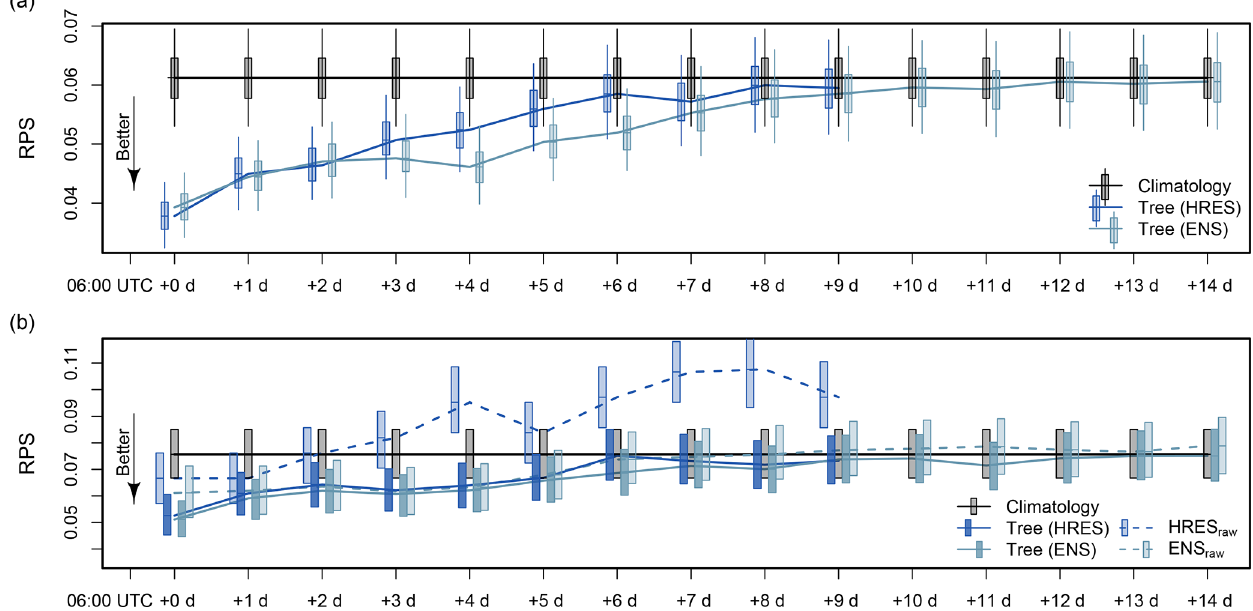
Figure 3. Medium-range forecast performance of boosting trees based on HRES and ENS information, and the reference models with their uncertainty (boxes show the 25th to 75th percentile range, and whiskers show the 5th to 95th percentiles). (a) Median forecast performance of the statistical models and climatology for the complete 6 years of data (cold season only). (b) Median forecast performance of the statistical models and the references climatology and raw NWP model output (HRES raw , ENS raw ) for December 2016–March 2017 and October– November 2017 only. The lvp state from the raw ensemble is computed from the distribution of the lvp states from each member. Computing the lvp state from only mean visibility and mean ceiling always results in lvp0. All lvp cases from the raw model output are due to low